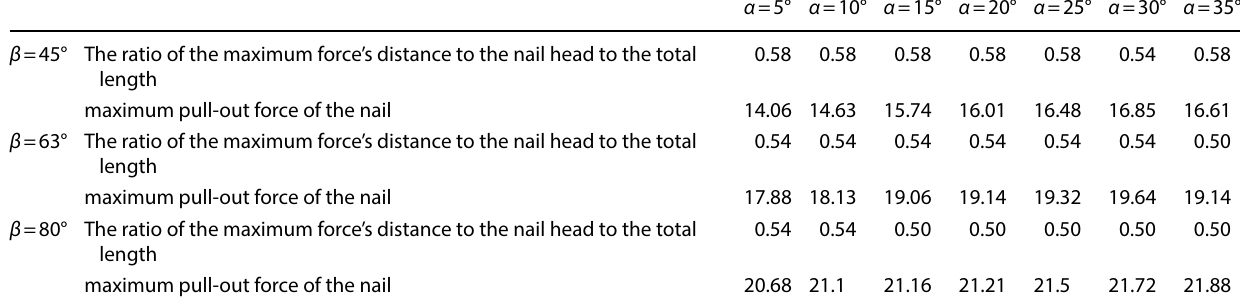
Table 6 The ratio of the maximum force’s distance to the nail head to the total length and the maximum nail force at various angles and